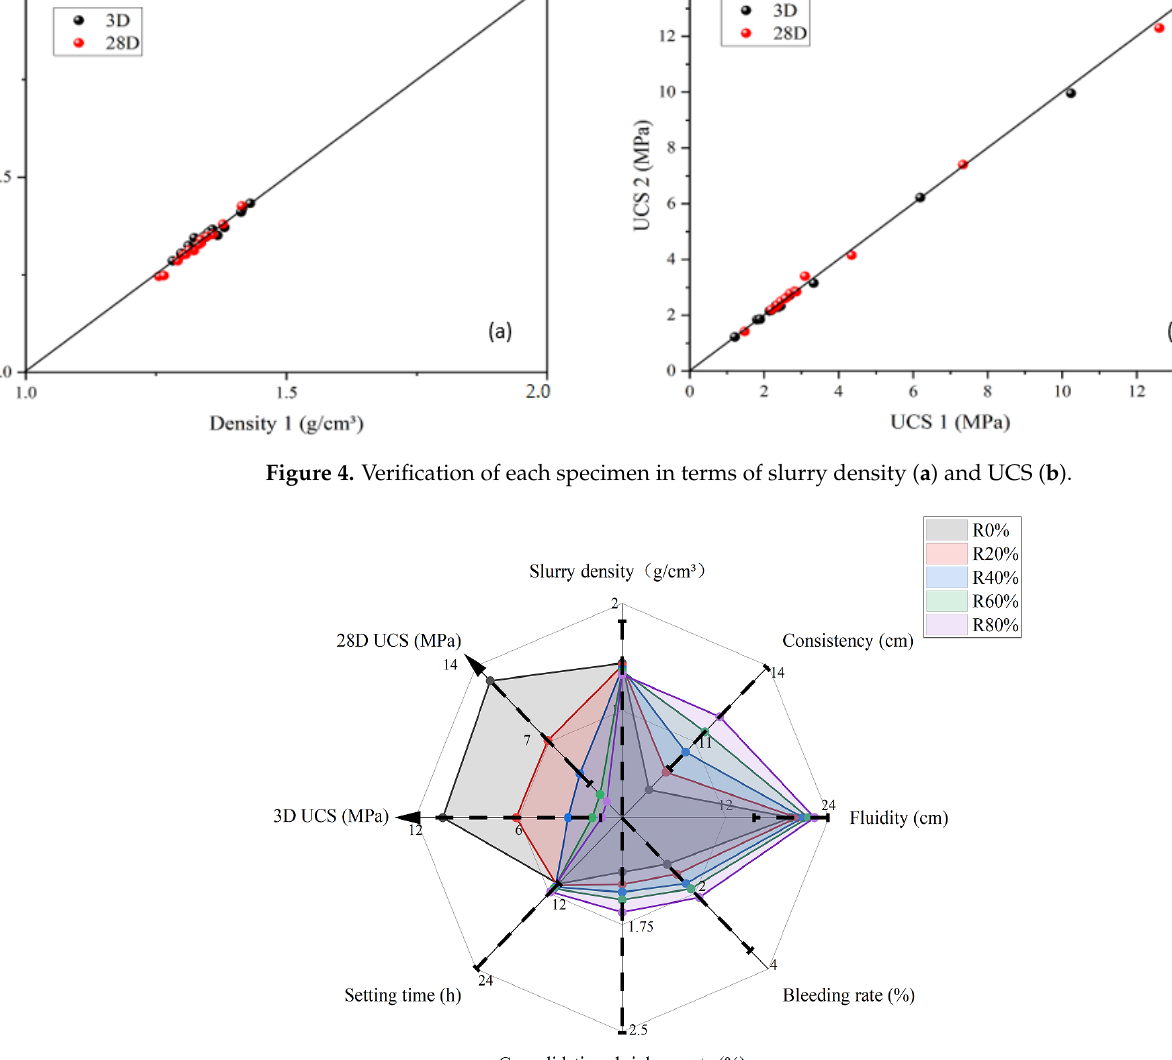
Figure 4. Verification of each specimen in terms of slurry density ( a ) and UCS ( b ).